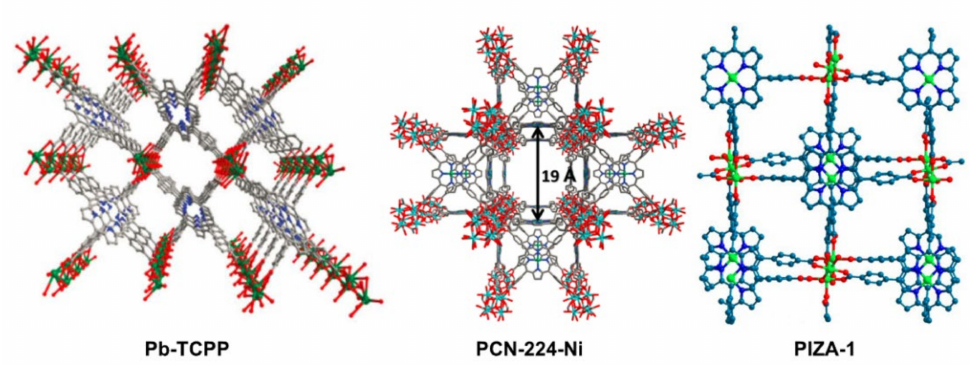
Figure 8. Porphyrin-based metal–organic frameworks for heterogeneously electrochemical OER. Reprinted with permission from ref. [64]. Copyright The Royal Society of Chemistry 2016. Reprinted with permission from ref. [65]. Copyright The Royal Society of Chemistry 2016. Reprinted with permission from ref. [66]. Copyright The Royal Society of Chemistry 2017.